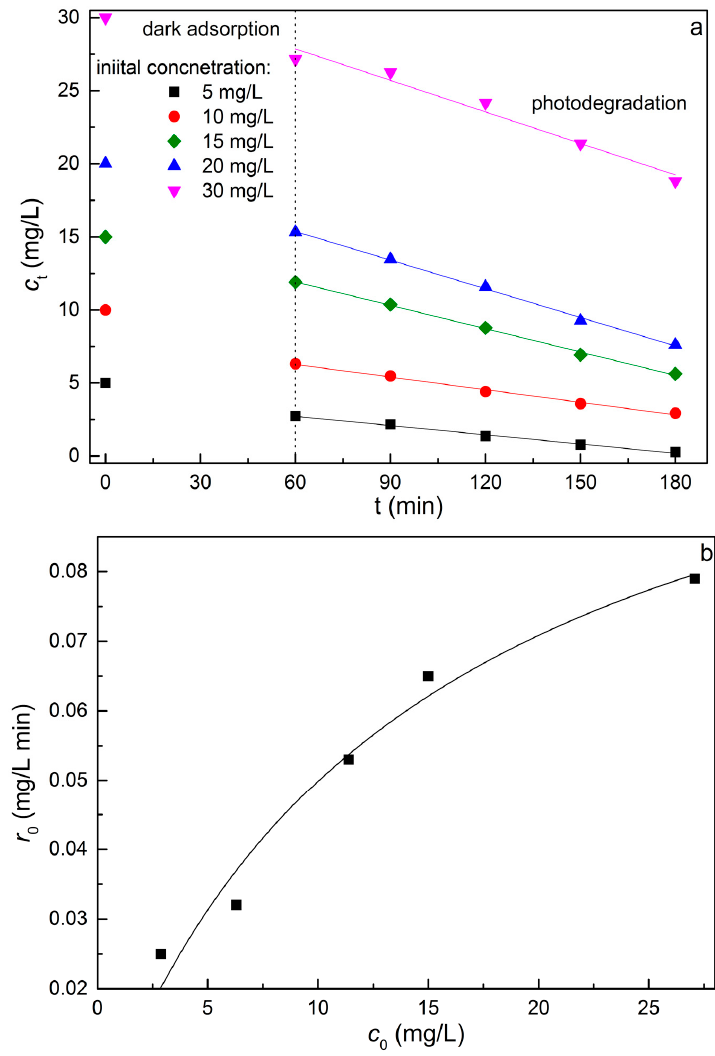
Figure 9. ( a ) Correlation between the initial rate of loss of MB dye on REC/Fe 3 O 4 /ZnO (1:0.3:0.5) and